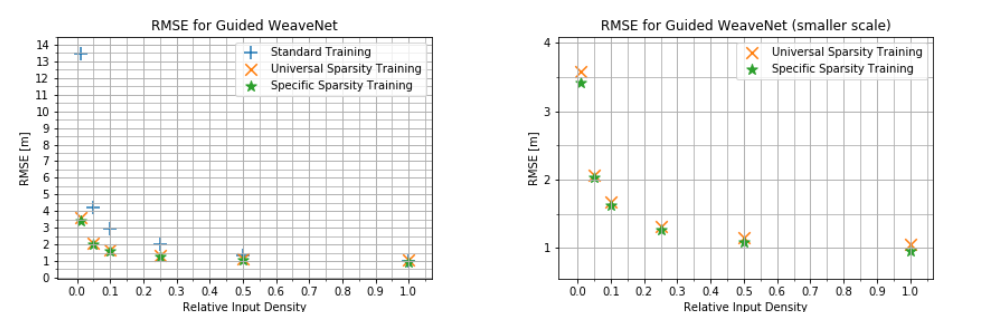
Figure 7. RMSE for the guided WeaveNet for various input densities for different training modes (different